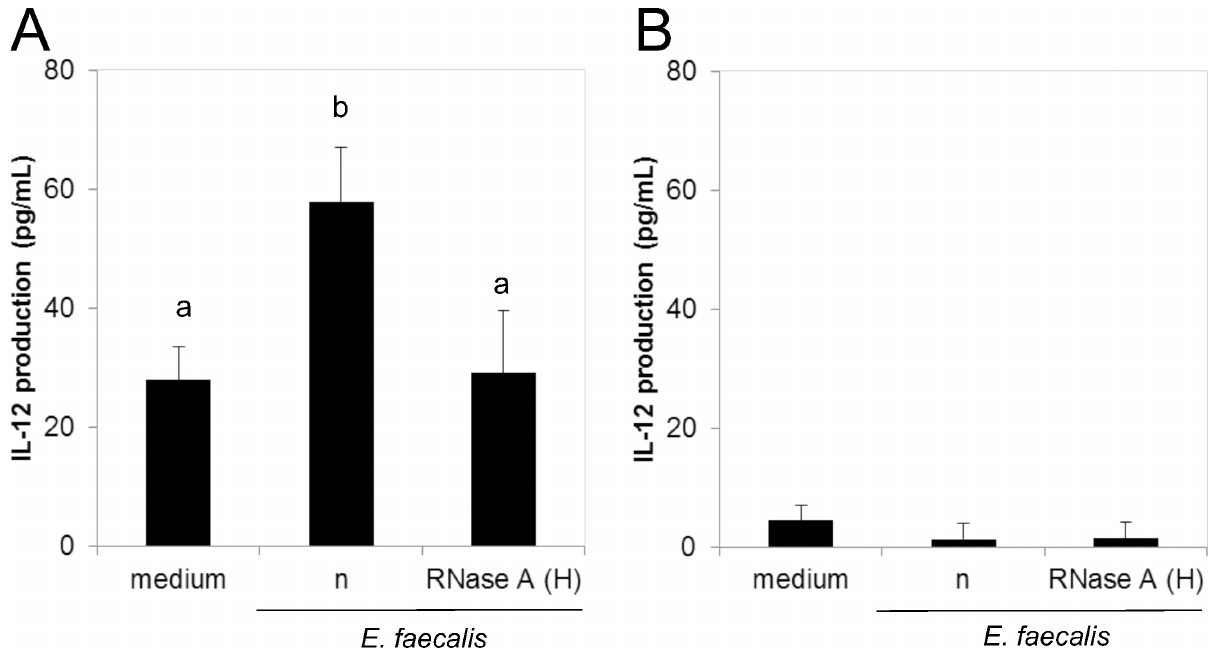
Fig 2. IL-12 production from human (A) monocytes and (B) monocyte-depleted PBMCs against E . faecalis EC-12. Heat-killed E . faecalis EC-12 was treated with or without RNase A in high salt buffer and co-cultured with (A) monocytes or (B) monocyte-depleted PBMCs for 24 h. The IL-12 protein concentration in the culture supernatant was measured by enzyme-linked immunosorbent assay. Bars sharing the same letter are not significantly different at P < 0.01, mean ± SD, n =